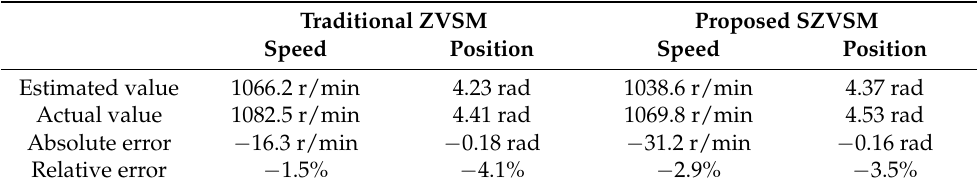
Table 3. Estimated error of initial speed and rotor position. Traditional